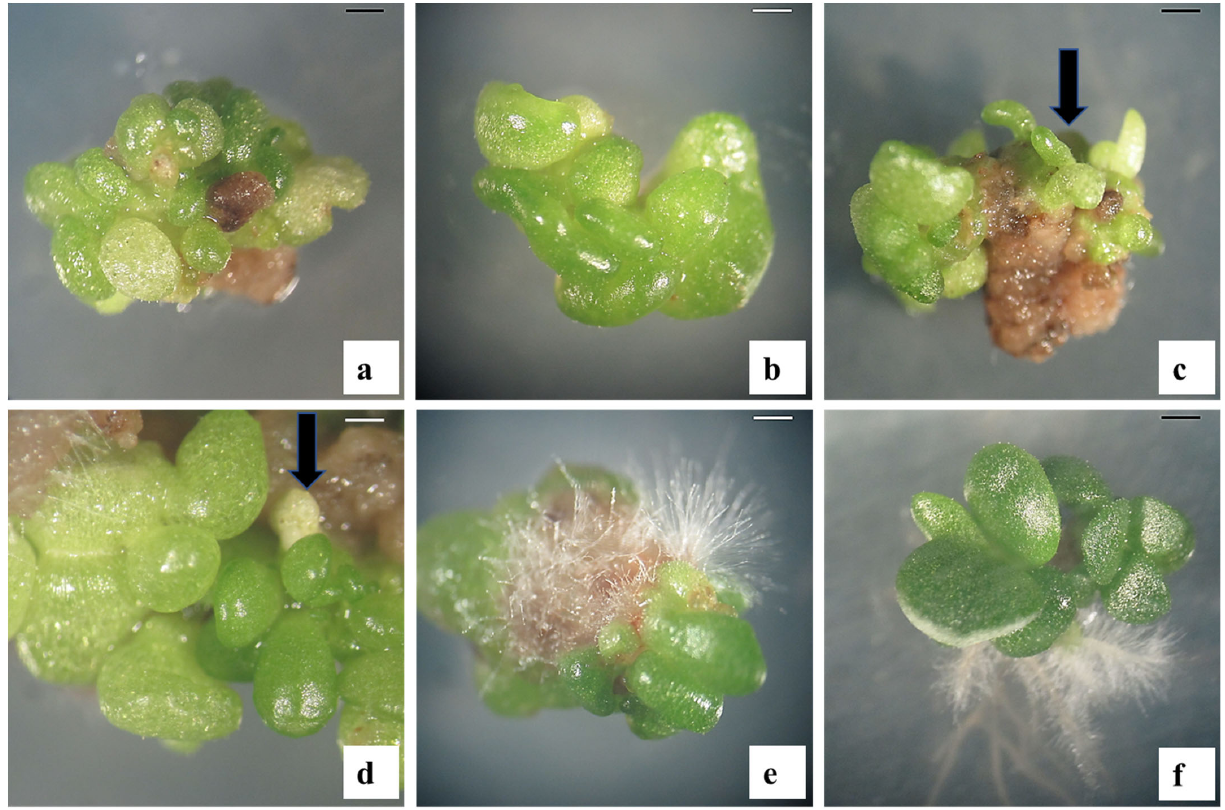
Figure 1. SE and plant regeneration from leaf explants of C. orbiculata : ( a ) initiation of globular ‐ shaped SoE on MS medium with 25 μ M 2,4 ‐ D (8 weeks); ( b ) formation of heart ‐ shaped SoE on MS medium with 25 μ M 2,4 ‐ D and 1.2 μ M TDZ (10 weeks); ( c ) formation of the torpedo (arrow) shaped SoE on MS medium with 25 μ M 2,4 ‐ D and 1.2 μ M TDZ (12 weeks); ( d ) formation of cotyledonary (arrow) shaped SoE on MS medium with 2 μ M GA 3 (5 weeks); ( e ) germination of SoE (8 weeks); ( f ) C. orbiculata plantlets from SoE (10 weeks). Scale bar. ( a – f ) 1.0 Table 2. Effect of combinations of 25 μ M 2,4 ‐ D and cytokinins on SE in C. orbiculata .